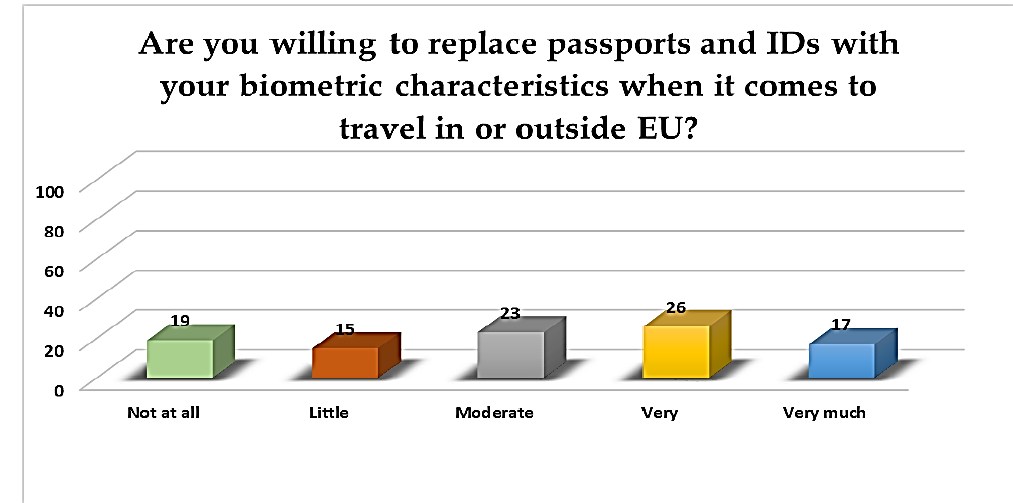
Figure 21. BS — replacing passports with BSs . Figure 21. BS—replacing passports with